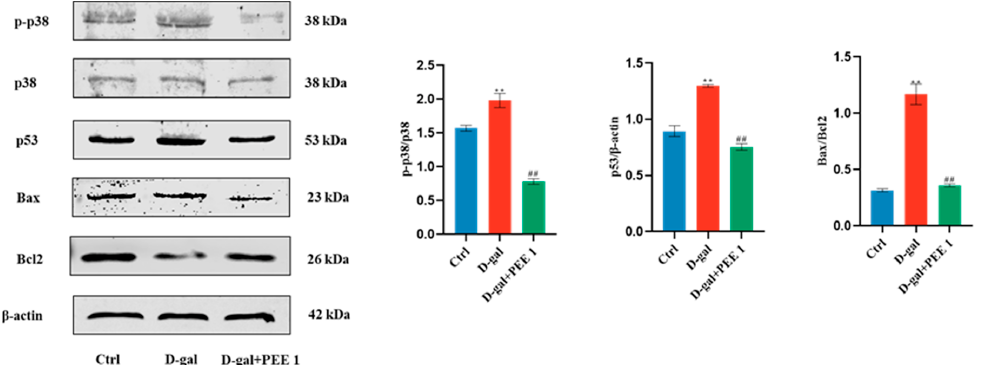
Figure 5. PEE inhibited D-gal-induced apoptosis in C2C12 cells by the p38/p53 signaling pathway. All data are expressed as mean ± SEM (n = 3). ** p < 0.01 vs. Ctrl; ## p < 0.01 vs. D-gal.